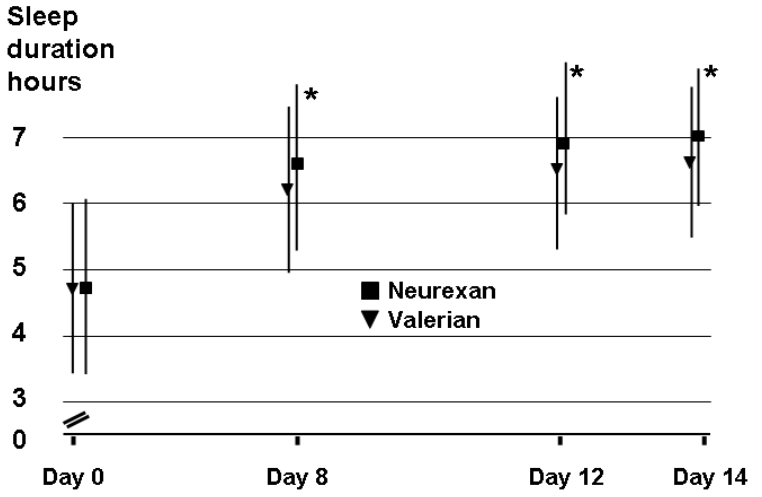
FIGURE 1. Mean estimated duration of sleep (hours) at time points with changes from baseline differed significantly between treatments (indicated by asterisks). Differences were in favor of Neurexan. Changes from baseline were significant for both groups. Lines indicate